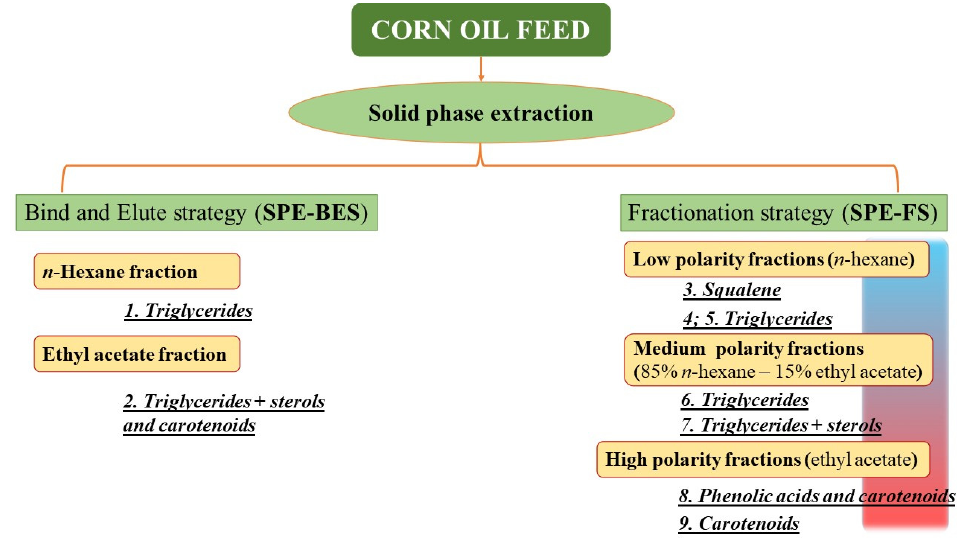
Figure 1. Work-up and the corresponding fractions.